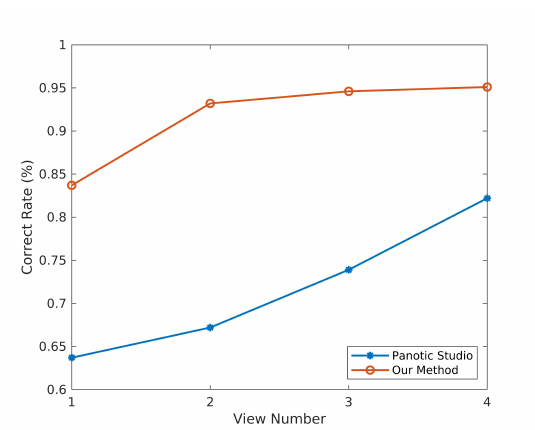
Figure 9. Results of different view groups.